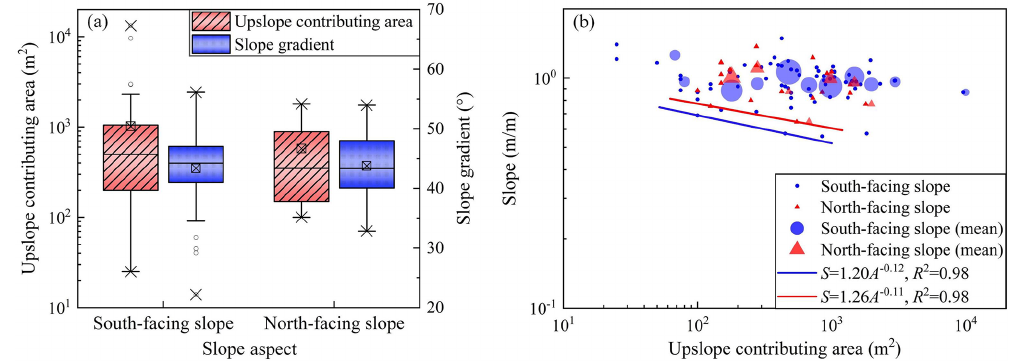
Figure 3. Upslope-contributing area and slope gradient condition, with the (a) upslope-contributing area and mean slope vs. slope aspect and (b) the upslope-contributing area vs. mean slope gradient above the landslide area. The definitions of the whiskers are shown in the caption of Fig. 2. The circles are averaged slopes, with the radius size proportional to the number of landslides. The small circles and triangles represent all individual data values. The power law regression is fitted with the dataset closet to the axis